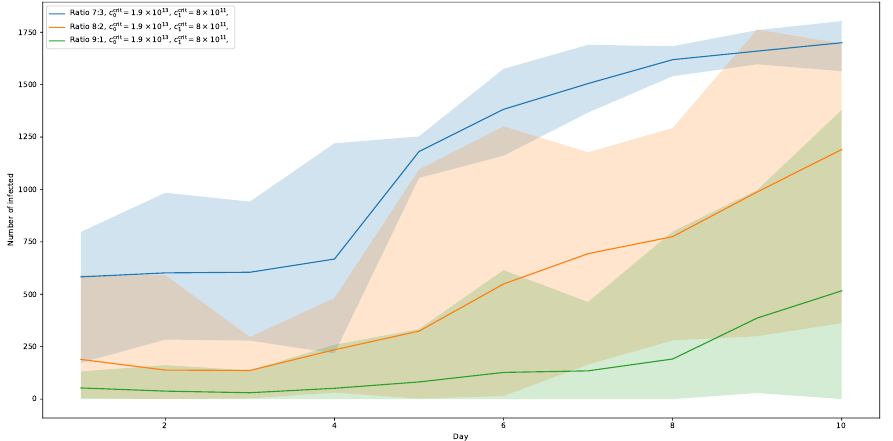
= 1.9 = 0.8 10 13 and c crit 10 12 . Here, the numbers for ratio 0 1 × ×